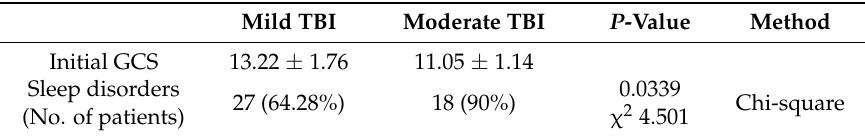
Table 4. Data for mild and moderate traumatic brain injury (TBI)